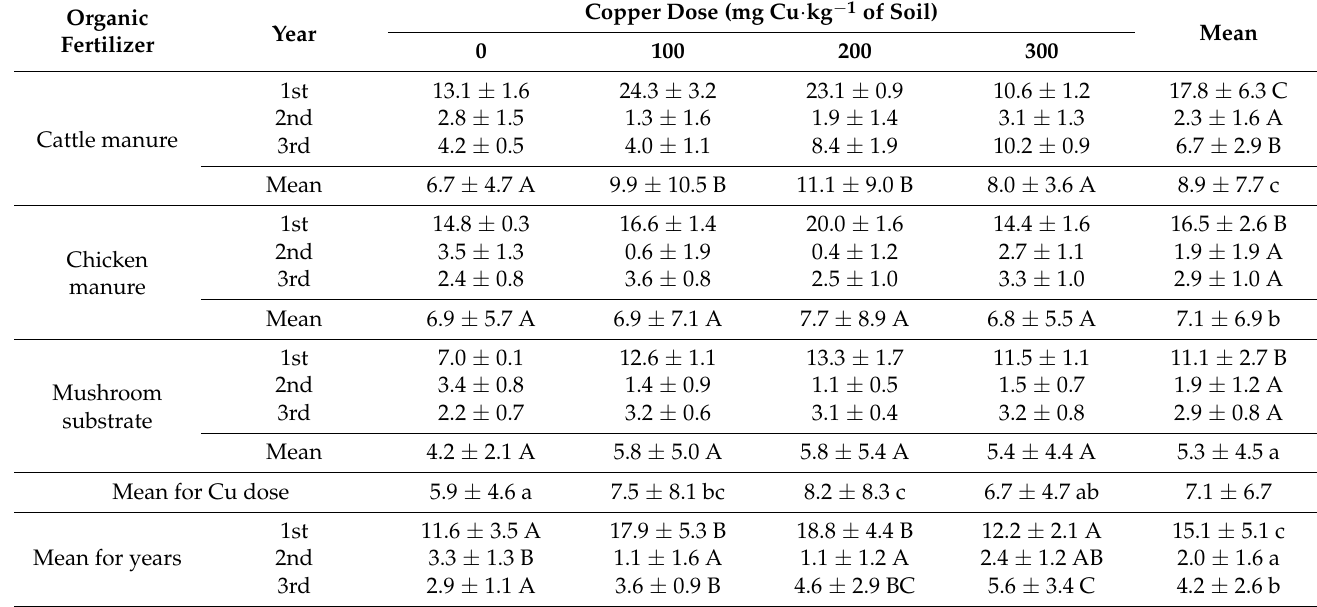
Table 6. Nitrogen utilization from organic fertilizers by cocksfoot, % (mean ±